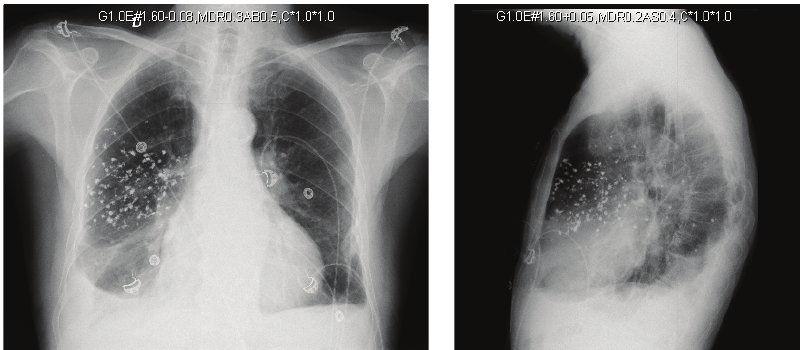
Figure 1: Chest radiograph in posteroanterior and lateral projections.